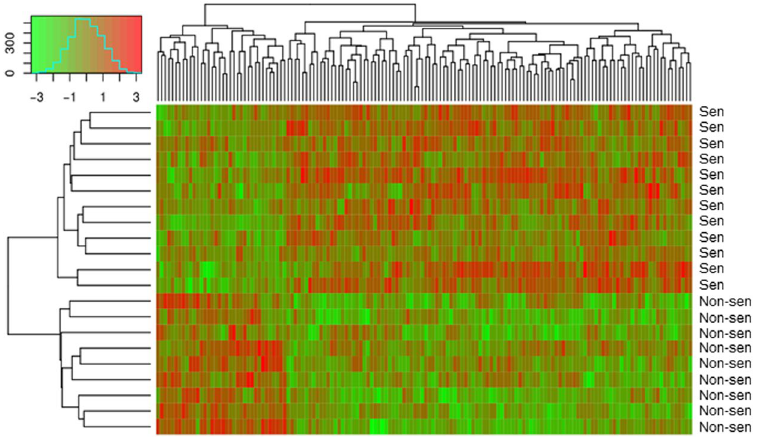
Figure 1. Heatmap of the first group of samples. Twenty-one samples were included in the first study. The rows represent the samples; the text at the right of each row describes the TPF sensitivity (Sen) or non-sensitivity (Non-sen) sample. The columns represent different expressed genes (DEGs). The color shows the expression levels of DEGs in the samples (z-score normalized by columns).